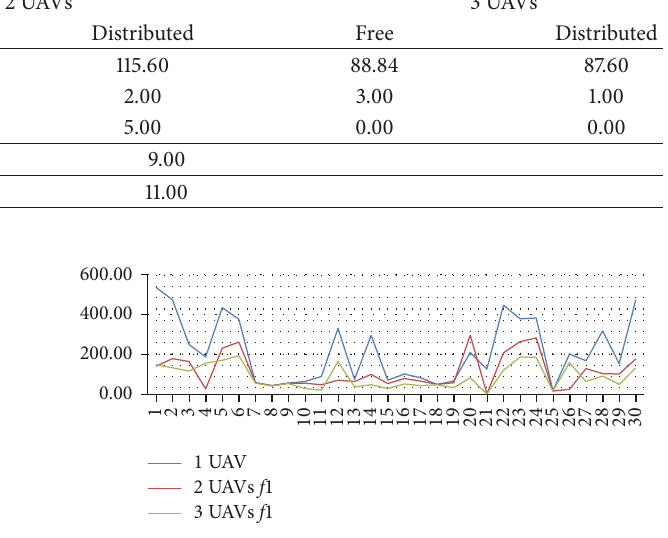
Figure 15: La Palma attraction path planning results for free swarm.